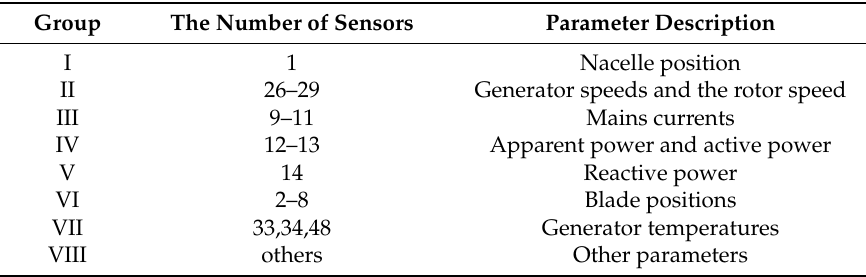
Table 1. The eight groups of the